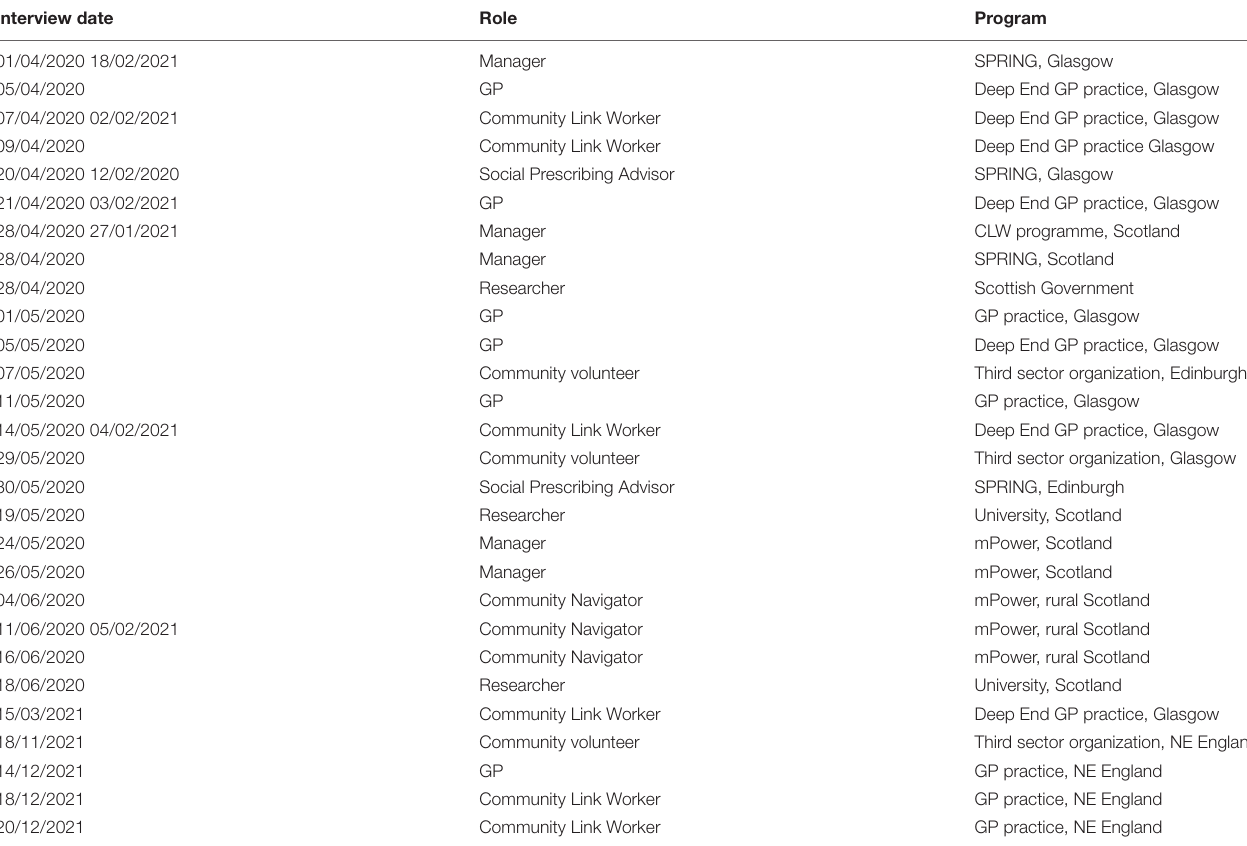
TABLE 1 | Key: table of participants with dates of interviews, role description, and work